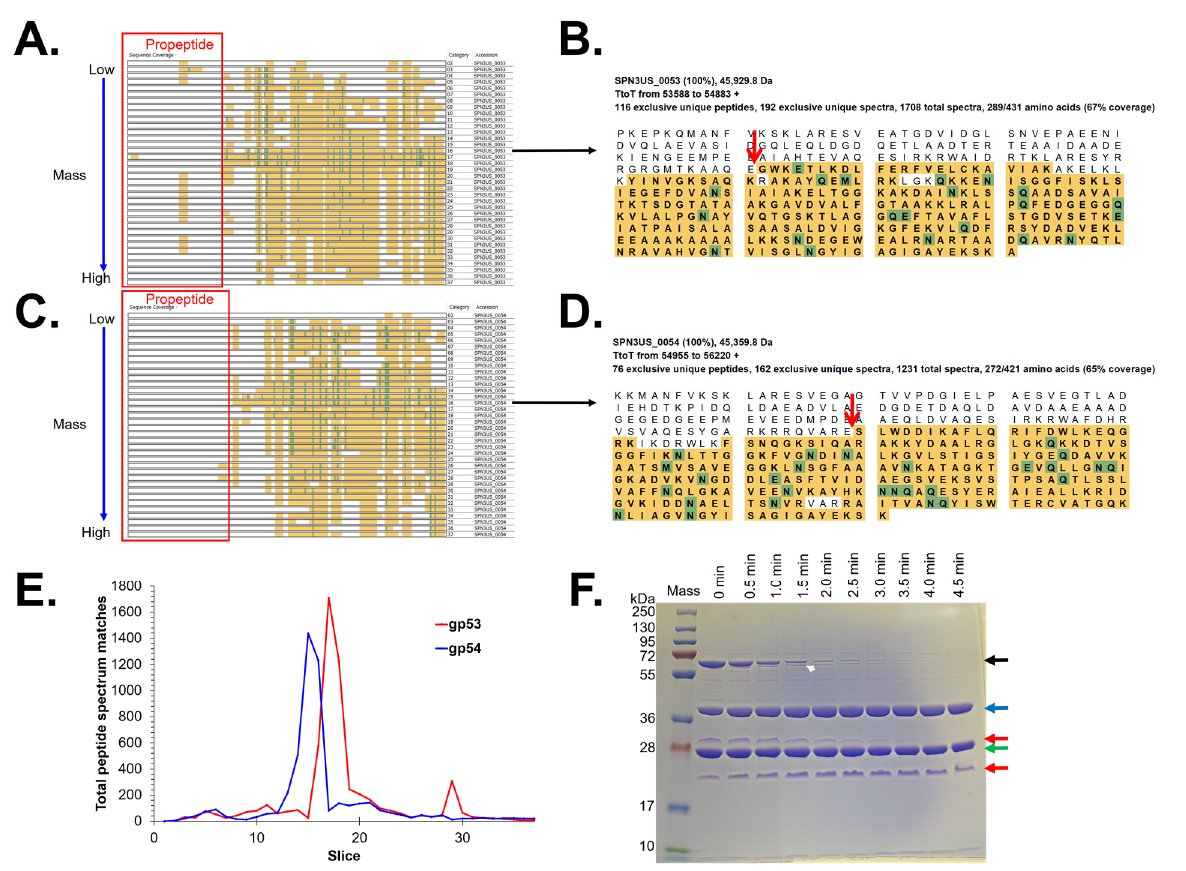
Figure 3. Proteolytic cleavage of SPN3US E proteins gp53 and gp54. ( A ) Sequence coverage map for gp53 in the 37-slice 1-D SDS-PAGE separation of head particle proteins (Figure 2). ( B ) Protein sequence coverage for gp53 in slice 17 showing its maturation cleavage site to generate the semi-tryptic peptide (E)GWKETLKDLFER(F) [red arrow; 57 peptide spectrum matches (PSMs) were assigned to that peptide]. ( C ) Sequence coverage map for gp54 in the 37-slice 1-D SDS-PAGE separation of head particle proteins (Figure 2). ( D ) Protein sequence coverage for gp54 in slice 16 showing its maturation cleavage site to generate the semi-tryptic peptide (E)SLWDDIK(A) [red arrow; 18 peptide spectrum matches (PSMs) were assigned to that peptide]. The maximum number of PSMs for gp54 is in slice 15—in agreement with the location shown in Figure 2. ( E ) Plot of the total PSMs assigned for gp53 and gp54 per gel slice. ( F ) Cleavage of gp53 by recombinant gp245 in vitro at room temperature. Black arrow, full-length gp53; red arrows, propeptide fragments of gp53, blue arrow, mature form of gp53; white arrow, a high molecular mass fragment of gp53 that may be the product of cleavage at ARE-12 (see Table 2).